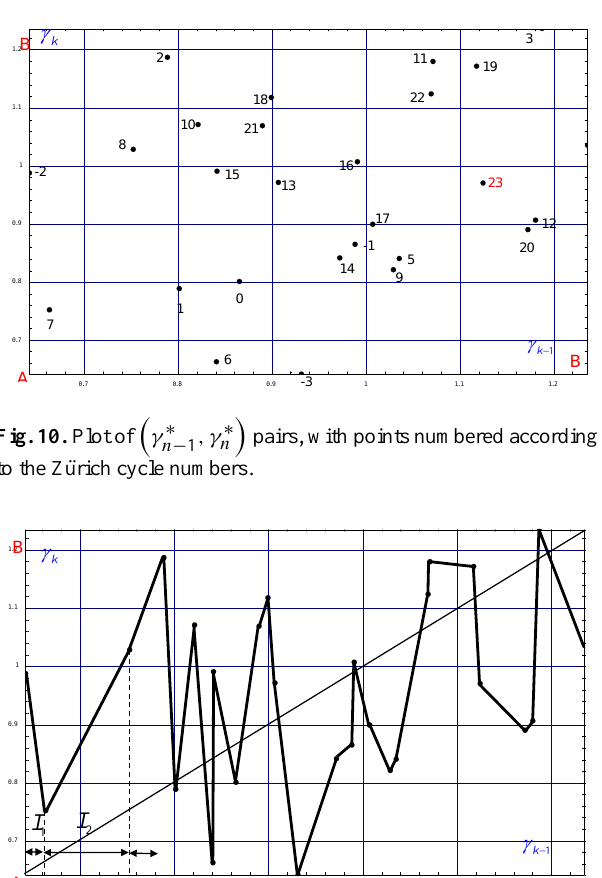
Fig. 11. Piece-wise linear approximation of the mapping φ , ob- tained by connecting neighbouring points (pairs) of Fig. 10 with straight